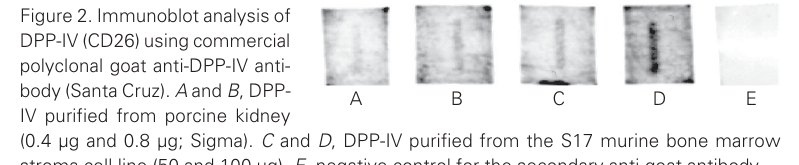
3. Analysis of DPP-IV en- zyme kinetics using glycine-pro- line-p-nitroanilide as substrate. Circles , Enzyme activity of the cell membrane-associated en- zyme. Squares , Enzyme activity in the cell culture supernatant. A typical assay is shown, with the curves that represent the best adjustment values for enzyme ki- netics calculated from fittings of the Michaelis-Menten equation to the experimental data.